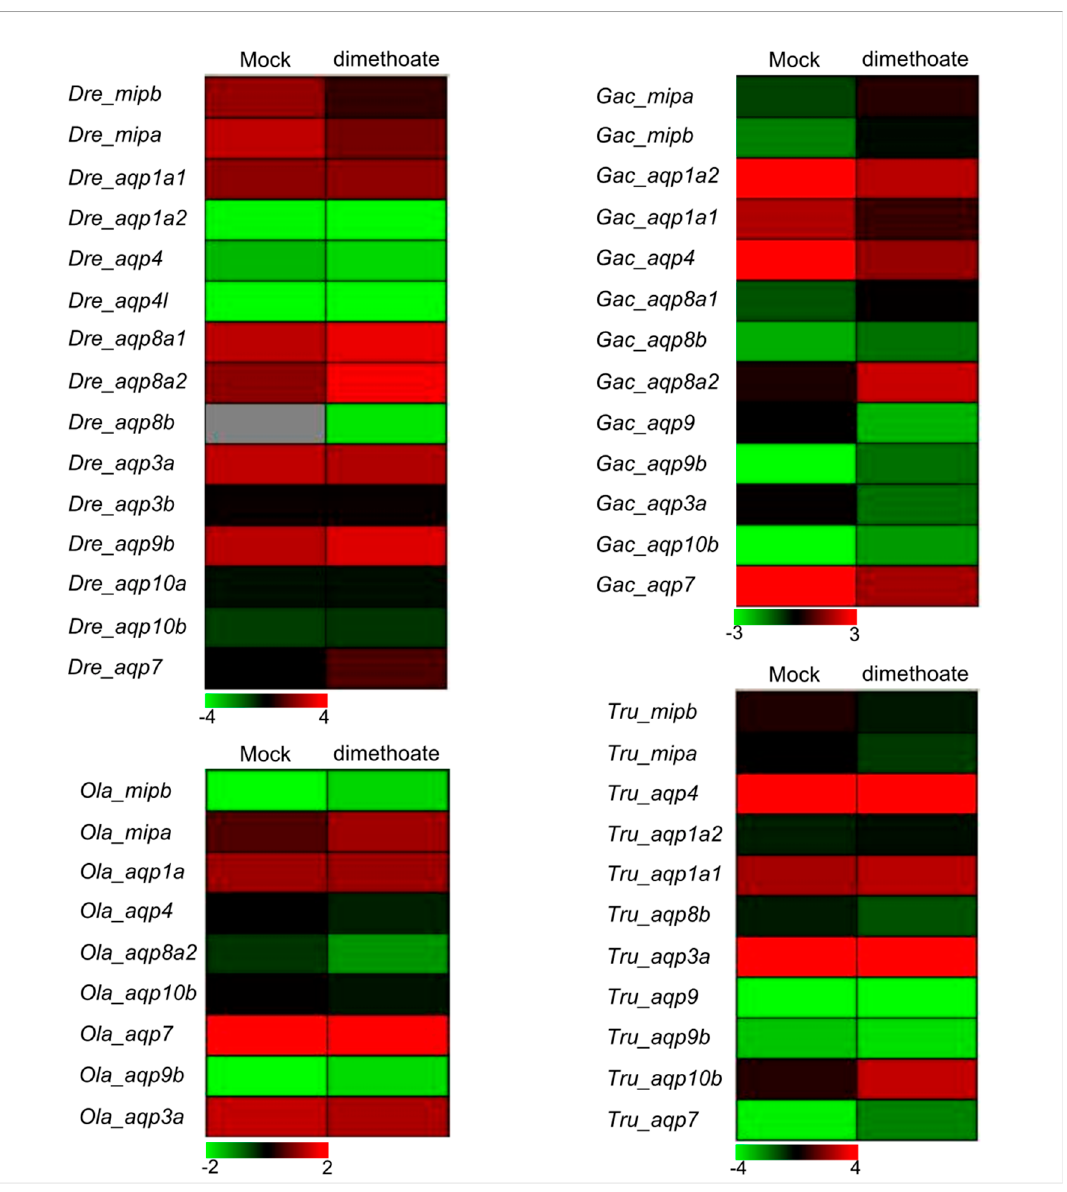
Figure 6. Expression profiles of zebrafish, medaka, stickleback, and fugu Aqp genes under dimethoate (one organophosphorus pesticide) stress based on transcriptome data.